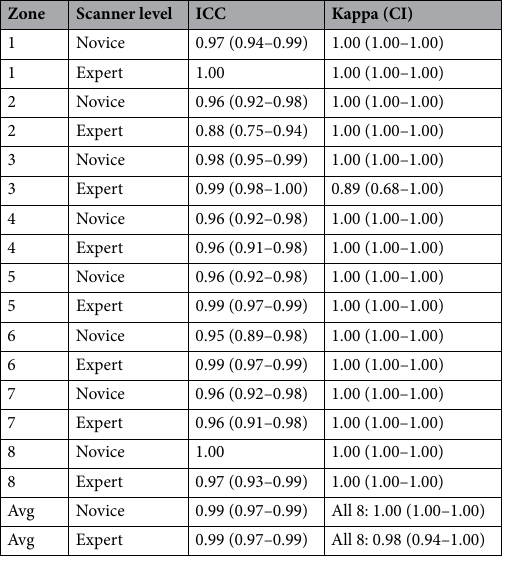
Table 3. Inter-rater reliability for scores of novice- and expert-obtained clips. Kappa values are reported for comparing clips rated as interpretable. CI confidence